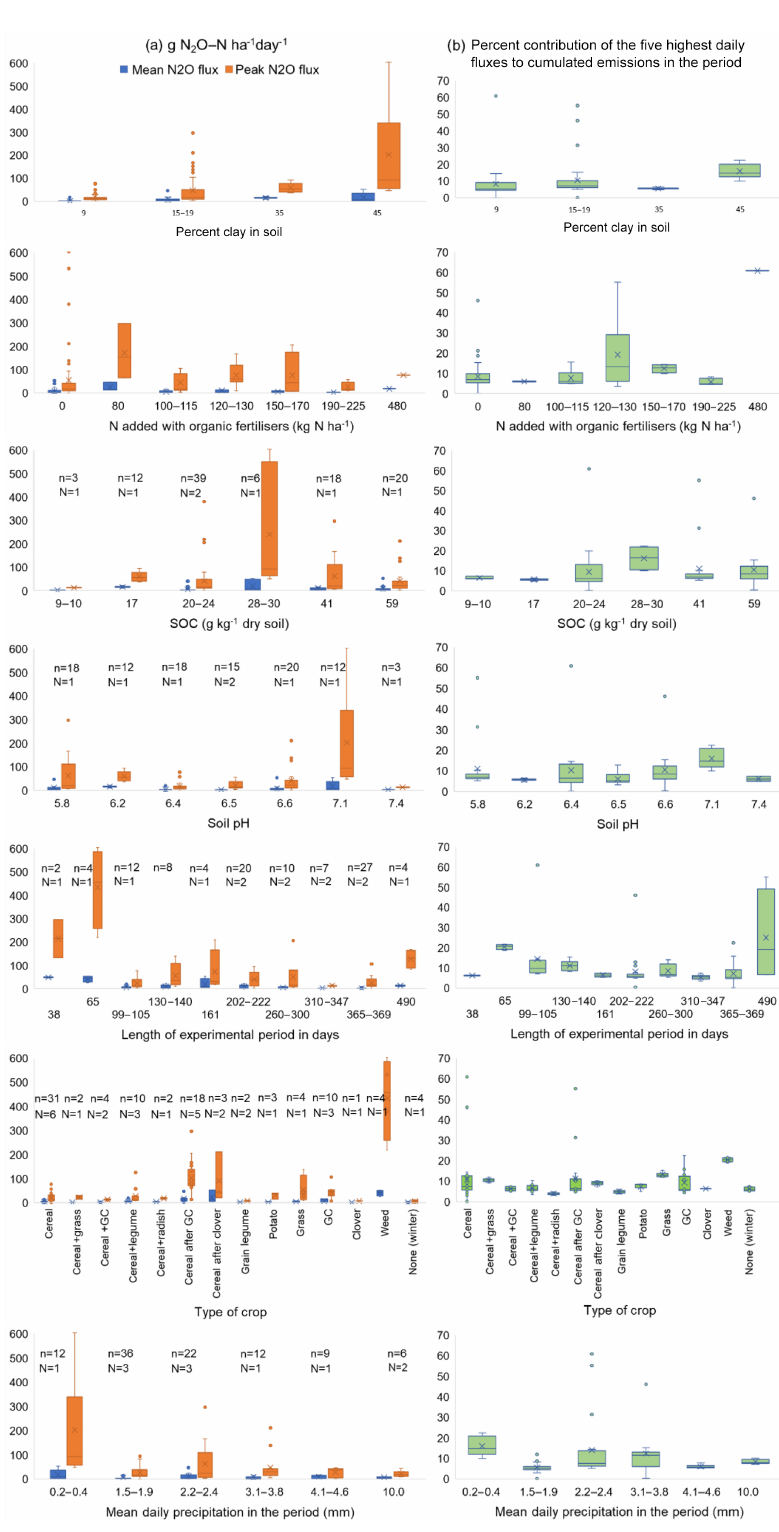
Figure 2. Box plot (the lines in the boxes indicate the mean, the crosses indicate the median, and the whiskers indicate the upper and lower quartile) for (a) the mean N 2 O flux in the period (gN 2 O–Nha − 1 d − 1 ) and the highest daily flux rate in the same period (gN 2 O–Nha − 1 d − 1 ), and (b) the percent (%) contribution of the five highest daily fluxes to cumulated N 2 O emissions in the period. N denotes the number of sites, and n is the number of